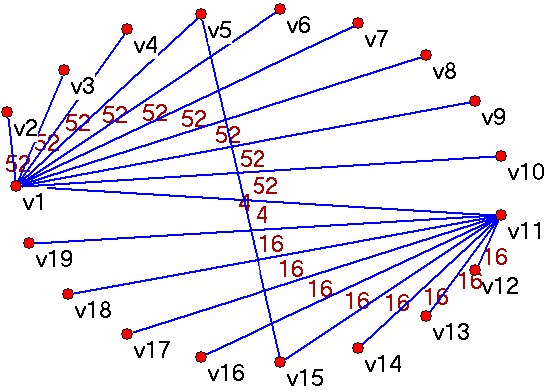
Figure 2. SCSG graph with STAR connectivity for the small folder with 19 files described in Table 1.